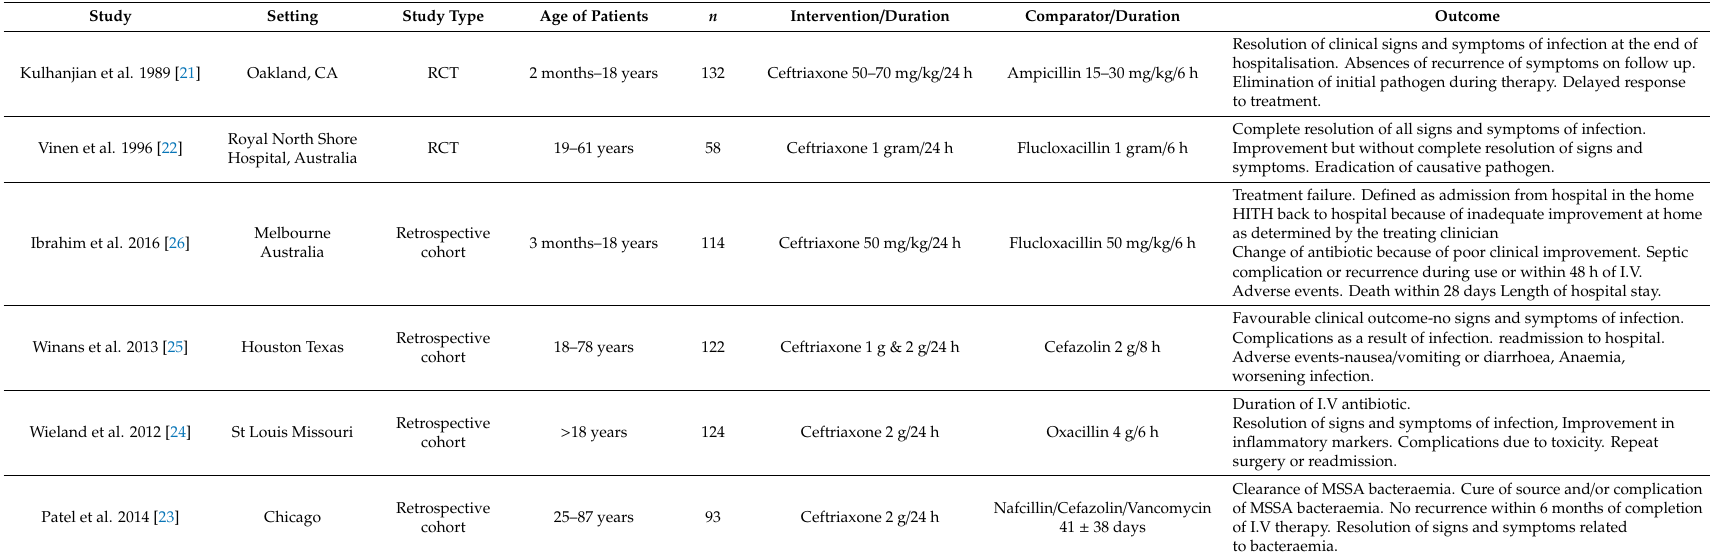
Table 1. Charicharistics of included